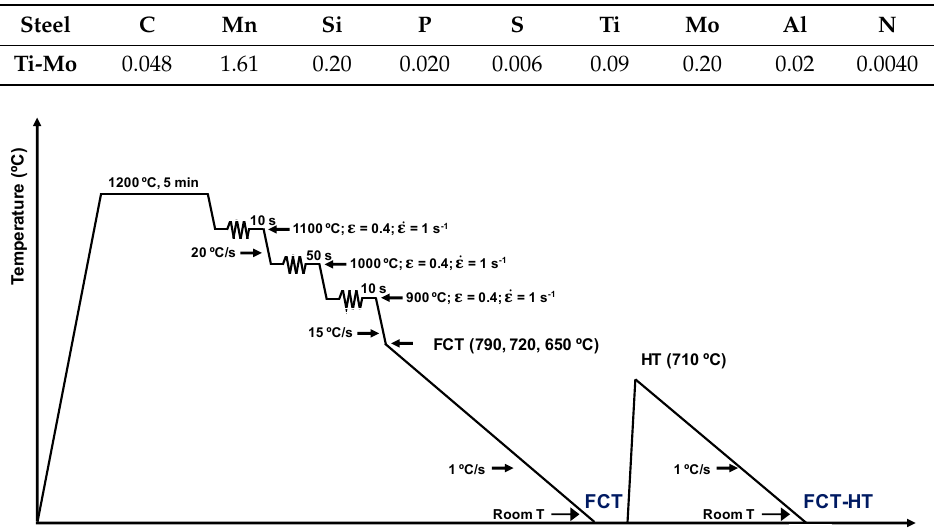
Table 1. Chemical compositions of the steels (weight percent).